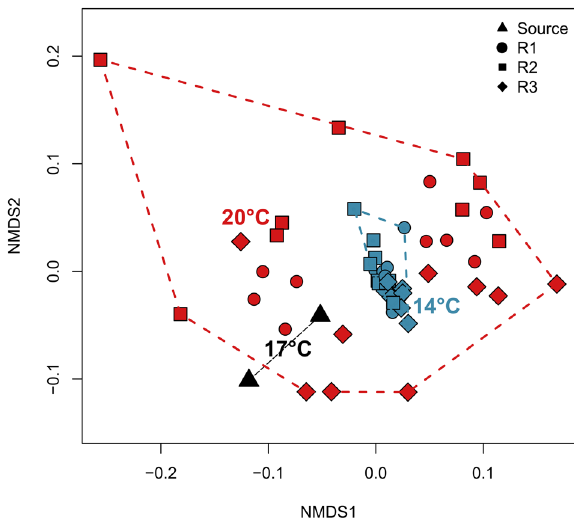
Fig. 4 Transcriptomic differences on the community level. nMDS analysis based on Jaccard dissimilarities depicting overall gene expression during the time-points of the experiment under different temperatures. Colors of clusters denote the respective temperature of the experiment (black: Inoculum, red: 20 °C, blue: 14 °C). Symbols respresent the different reactors. Reactor1 is missing one Baseline sample of the 14 °C experiment